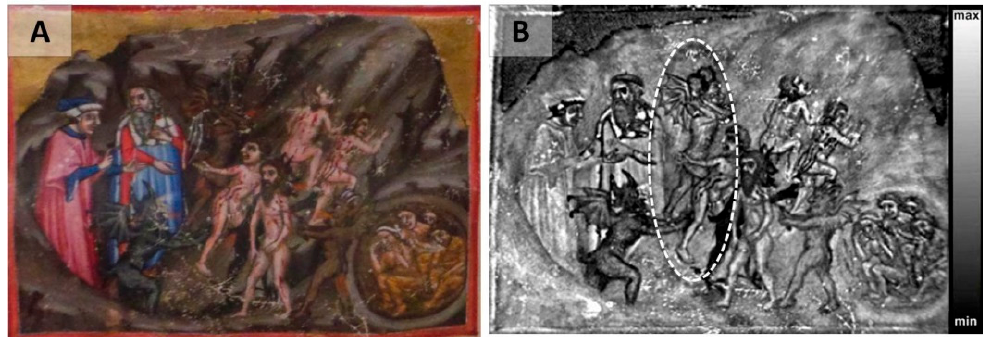
Figure 12. Commedia, XIV century, Biblioteca Angelica of Rome. ( A ) Photograph of the illumination of folio 15 verso ; ( B ) thermogram where the dashed circle marks the demon.